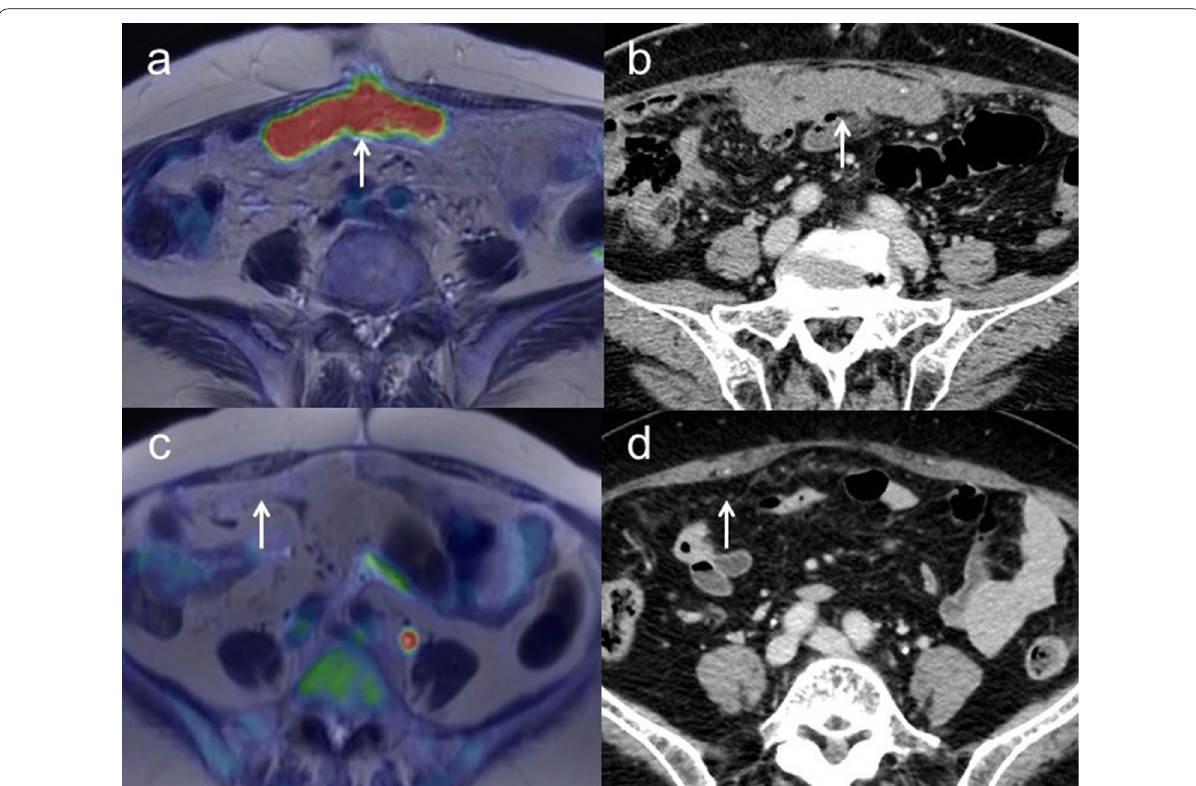
Fig. 5 a A 71-year-old woman with ovarian cancer showing carcinomatous peritonitis and pleural effusion confirming the presence of malignant cells. After NAC, axial T2-weighted PET/MR image shows the omental cake with FDG uptake (arrow). b Contrast-enhanced CT shows the thickened omentum with slight enhancement (arrow). These findings strongly suggested potential residual disease, which was confirmed by histopathologic examination. c A 77-year-old woman with ovarian cancer with carcinomatous peritonitis and ascites confirming the presence of malignant cells. After NAC, axial T2-weighted PET/MR image shows the almost disappear of the omental cake and FDG uptake (arrow). d Contrast-enhanced CT also shows the almost disappear of thickness and enhancement of the omentum (arrow). These findings show the marked response to NAC. However, histopathologic examination confirmed residual disease comprising high-grade serous carcinoma with carcinomatous peritonitis